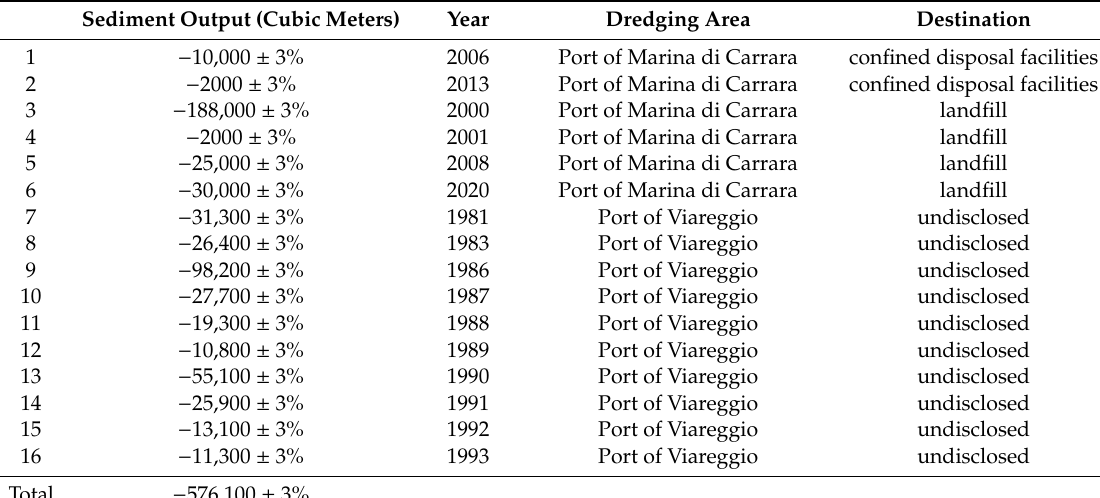
Table 2. Volume of sediments dredged from the harbor at Marina di Carrara and Viareggio, and not used for nourishment purposes in the 1980–2020 timespan along the considered sector of coast, sorted by destination.